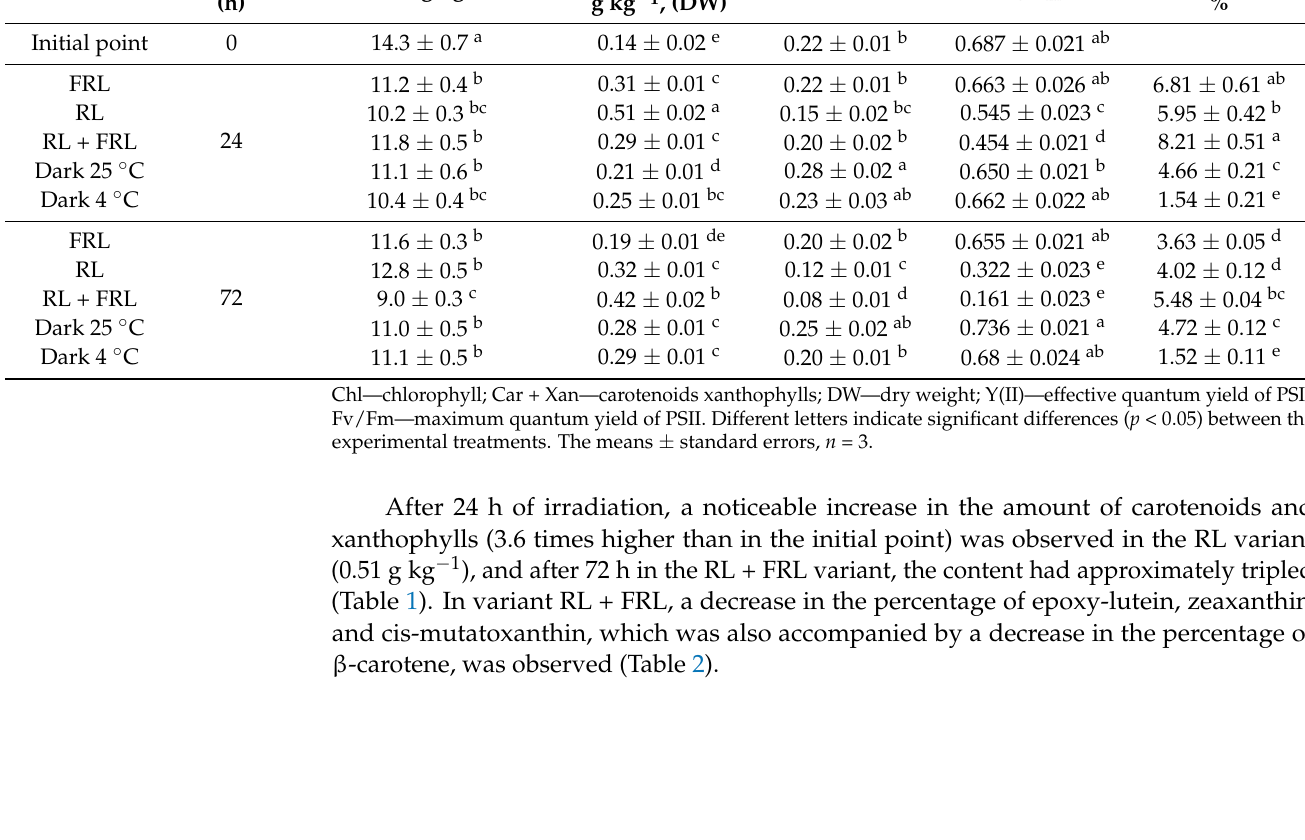
β -carotene, was observed (Table